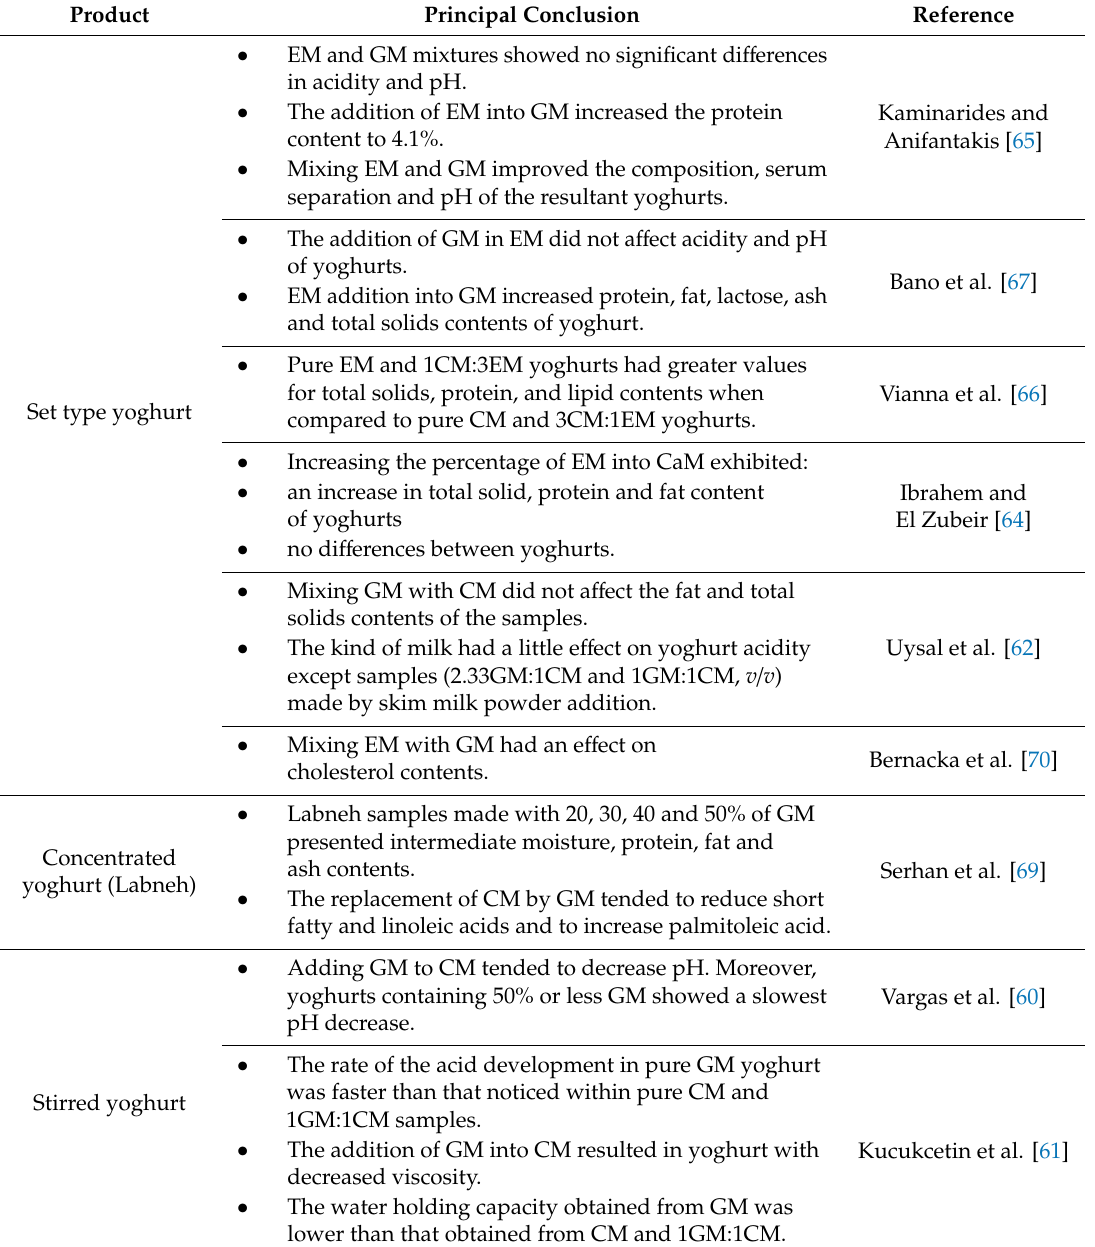
Table 3. Examples of principal conclusions of studies concerning the e ff ect of mixing milk from di ff erent species at di ff erent proportions on physicochemical and biochemical properties of